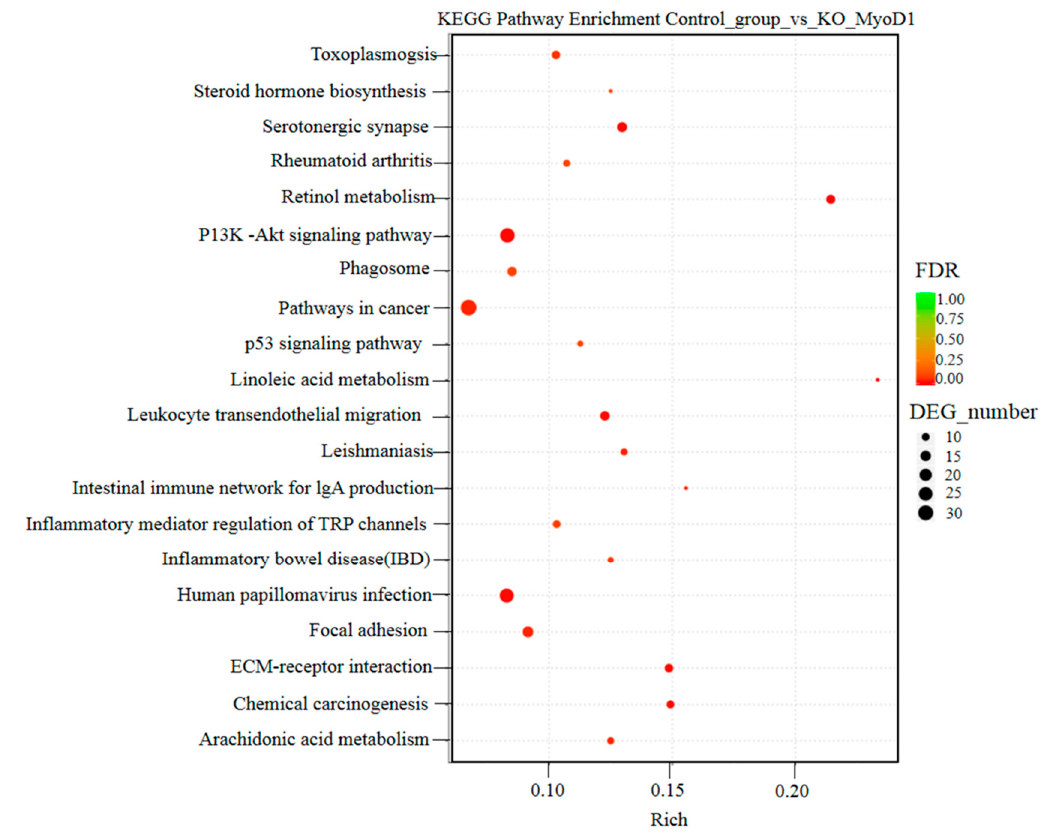
Figure 6. KEGG enrichment analysis of DEGs.